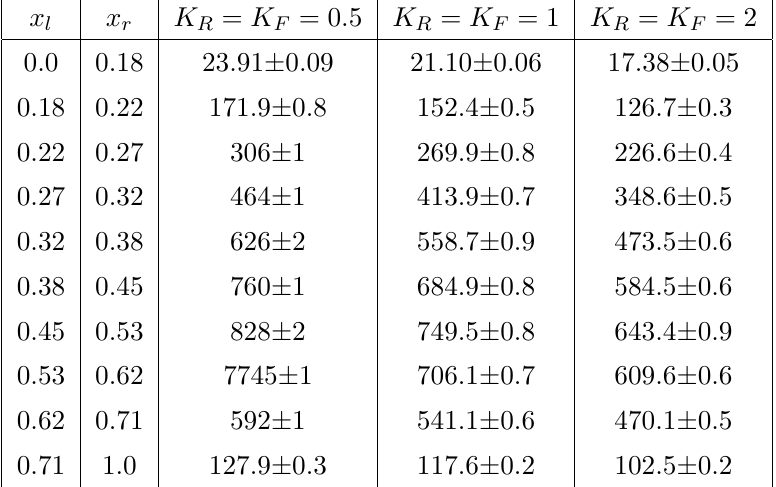
Table 4 . Same as table 3, but for µ 0 = H B